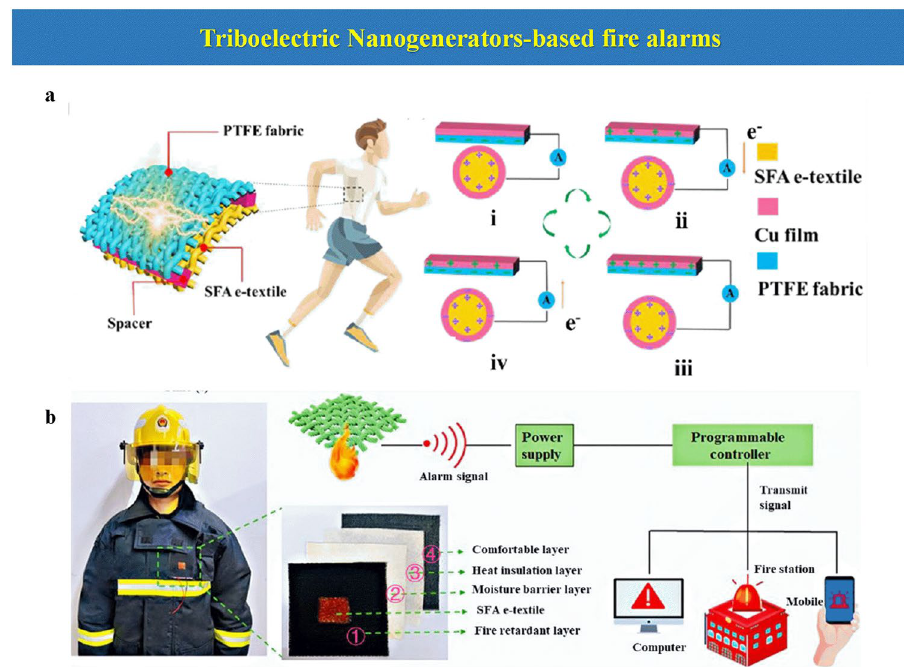
Fig. 12 a Basic electricity generation mechanism of the TENG by a vertical contact‑separation mode. b Temperature‑response resistance changes the behavior of the SFA e‑textile under different temperatures, and the operating mode of the SFA e‑textile as a fire alarm material in firefighting protection. Reproduced with permission from Ref. [54]. Copyright 2022 American Chemistry